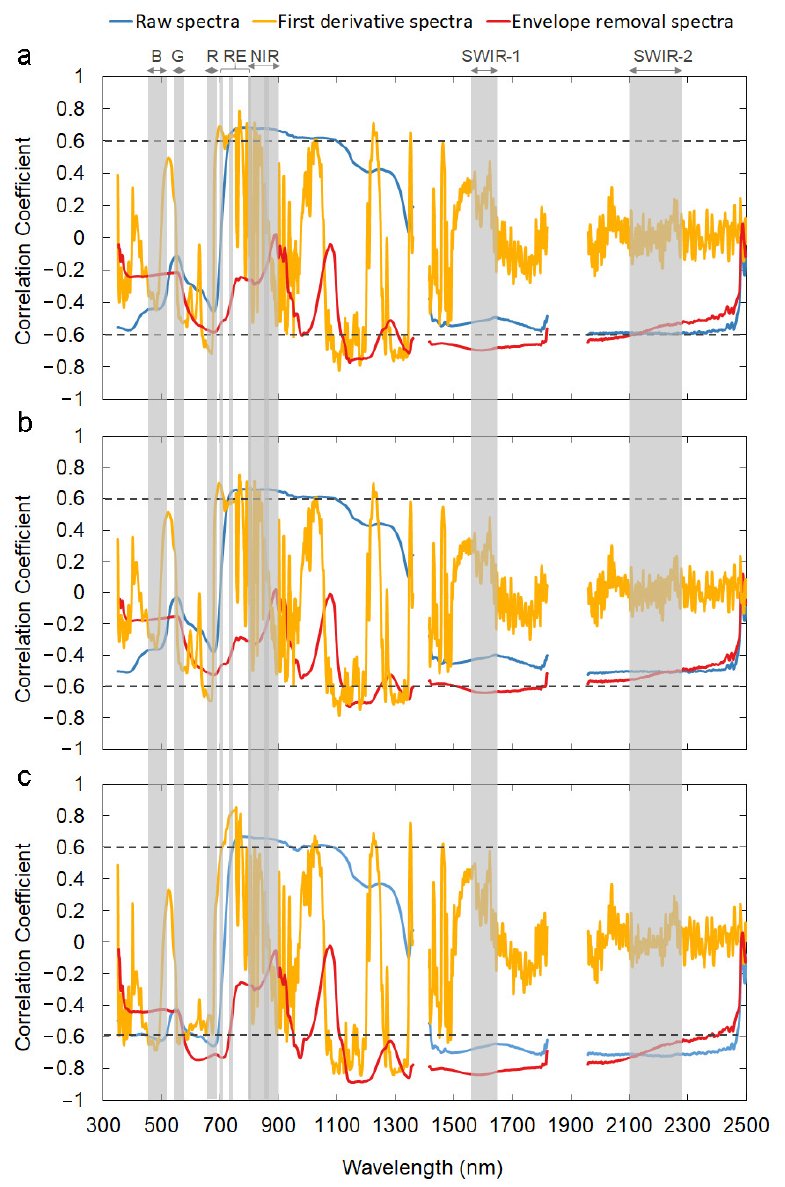
Figure 3. Correlation coefficients for forage biomass ( a ), crude fiber (CF area , b ) and crude protein per area (CP area , c ) with raw spectra (after denoising), first derivative spectra, and envelope removal spectra, respectively. The gray shaded areas indicate the spectral settings and resolutions of S2 images that can be potentially used to estimate forage biomass, CF area , and CP area . The visible spectra bands (blue: 458–523 nm, green: 543–578 nm, red: 650–680 nm); RE, Red-Edge bands (698–713 nm, 733–748 nm, 773–793 nm); NIR, Near Infrared Bands (785–900 nm); SWIR, Shortwave Infrared Bands (SWIR-1: 1565–1655 nm, SWIR-2: 2100–2280 nm).